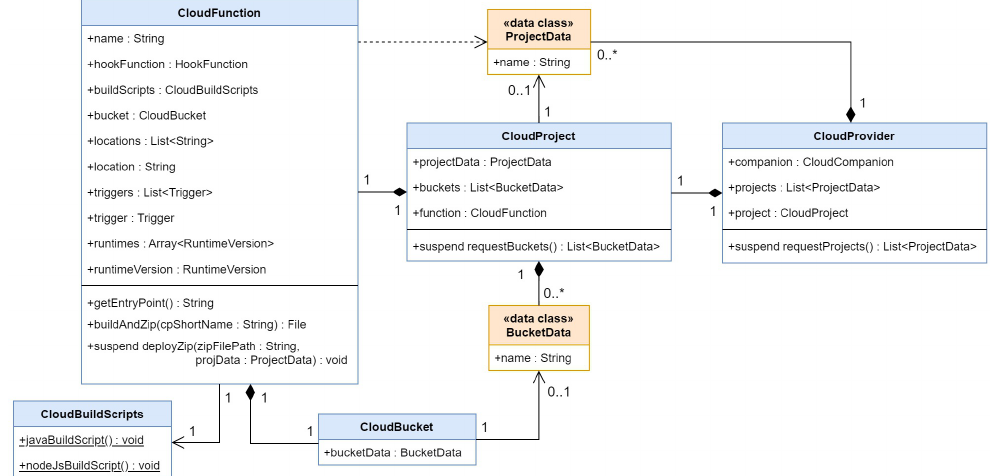
Figure 11. FaaS Deployment class